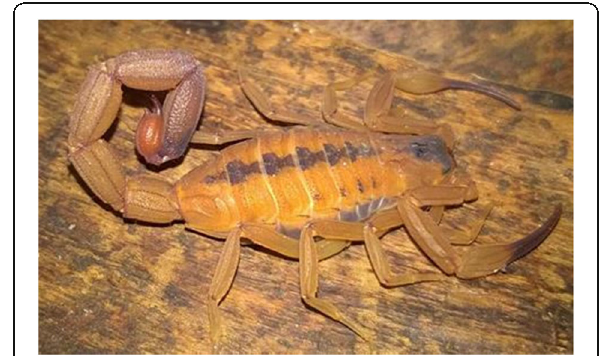
Fig. 3 Tityus stigmurus. The yellow scorpion of the Northeast resembles T. serrulatus in habits and coloration, but it shows a dark longitudinal band in the dorsal area. Adult specimens are black